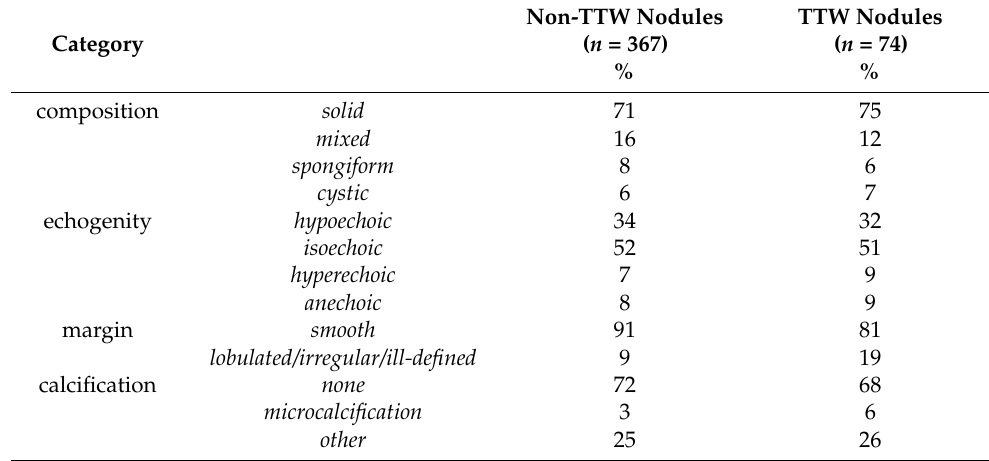
Figure 6. ( a , b ). The green circles represent typical benign nodule in the respective part of the thyroid gland. The size of each circle represents the frequency of nodules in the respective part (all parts together sum up to 100%, apart from rounding differences). The shape represents the typical relation of the sagittal diameter (tall) to the horizontal diameter (wide) of a typical nodule. Note that nodules at or in a horn are typically round (tall = wide) whereas nodules in other locations are elliptic (tall < wide) in particular in the thyroid isthmus (tall << wide). * Frequencies at the cranial, central, and caudal portions were 13%, 41%, and 25%, respectively. Configuration did not differ between these three locations for which reason they are given as one circle. $ including nodules at or in a horn. TTW nodules showed similar sonographic features to non-TTW nodules (Table 3). Table 3. Ultrasound features in non-TTW nodules and TTW nodules.